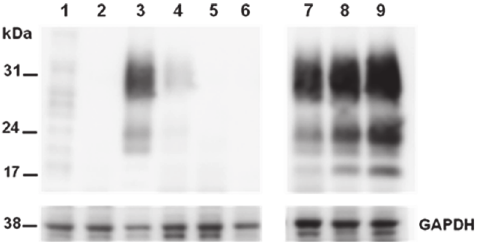
Figure 3. Comparison of persistently infective abilities on non-cloned and cloned cells successively passaged. Lane 1 and 2, normal MDBK C1 – 2F (without and with PK treatments); Lane 3 to 6, uncloned BSE-infected MDBK C1 – 2F (passage level; p11, p17, p24, and p27); Lane 7 and 9, cloned BSE-infected MDBK C1 – 2F (passage level; p15, p19, and p26). Molecular mass marker in kilodaltons (kDa) is shown on the left. Housekeeping protein, GAPDH (glyceraldehydes-3-phosphate dehydrogenase) was used as a control of comparative protein concentration. The result shown is representative of three independent